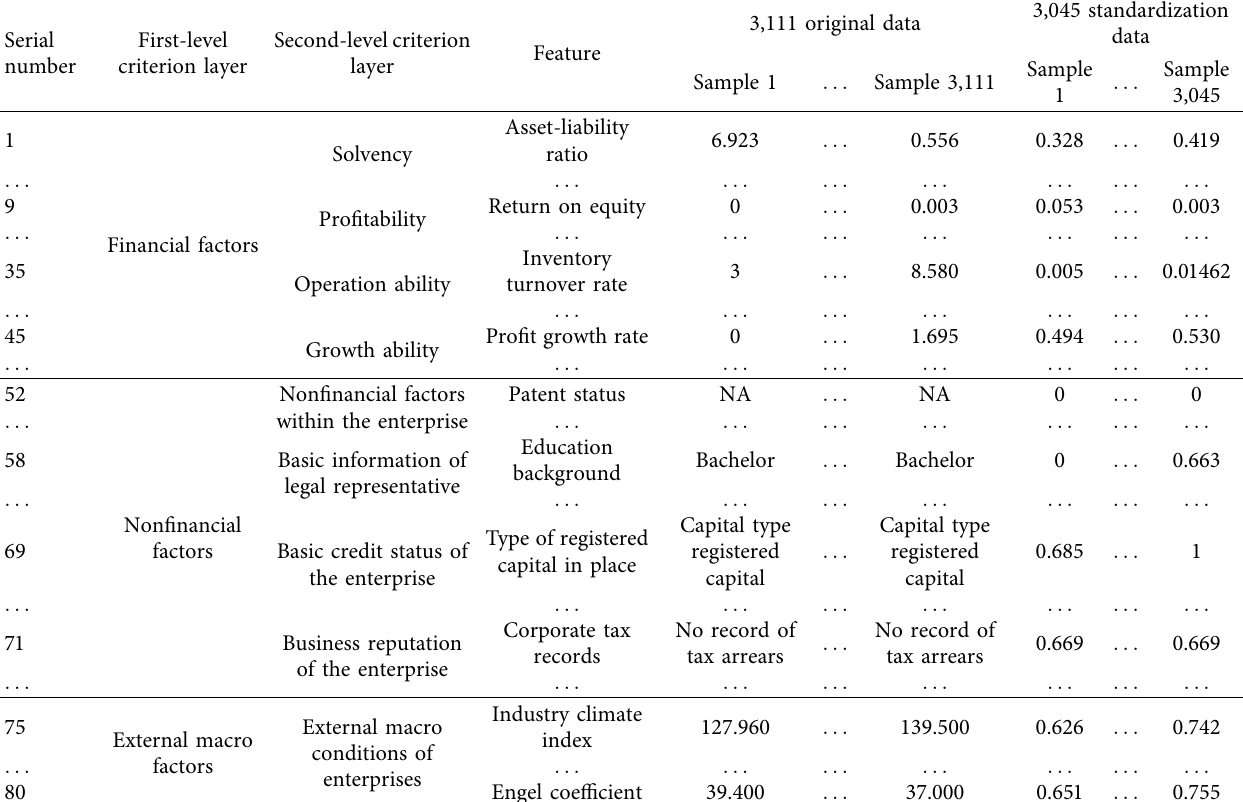
Table 2: The feature data of China